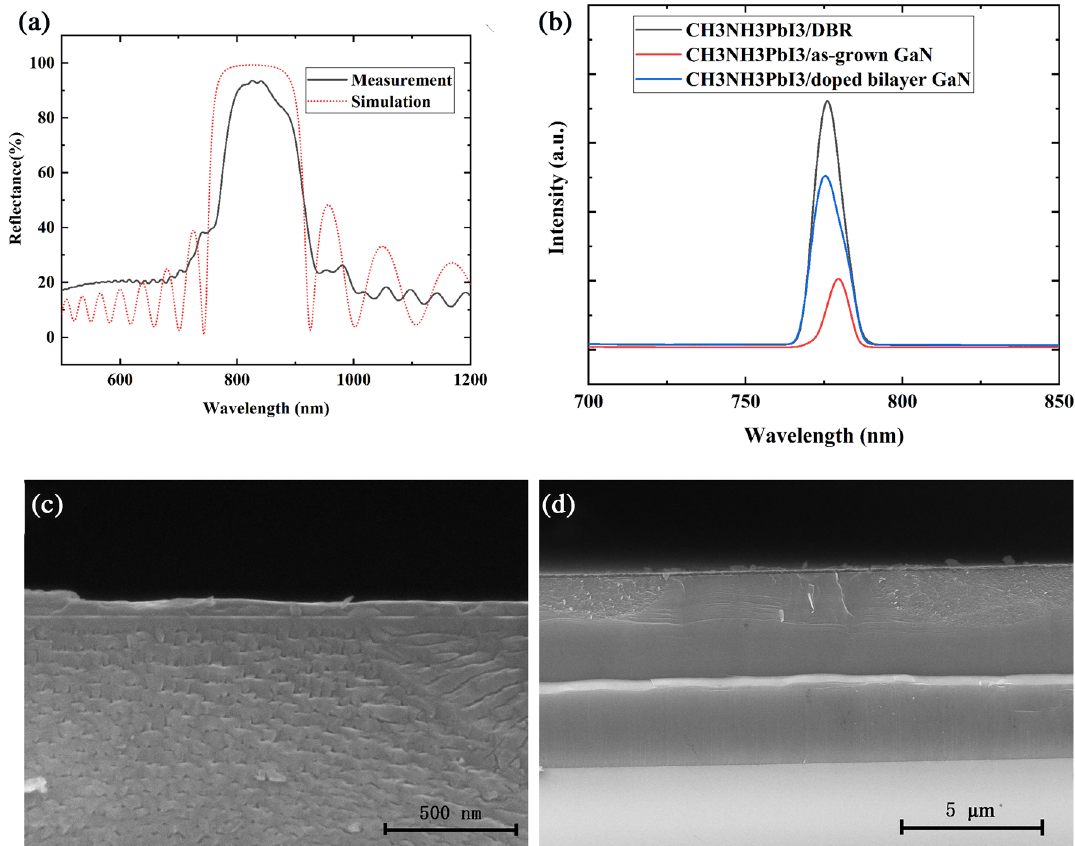
Figure 6. ( a ) The experimental and simulated reflectance spectra of the NP-GaN DBR. ( b ) The room- temperature PL spectra of the prepared perovskite films on the NP-GaN DBR, etched single-layer GaN and as-grown GaN substrates. ( c , d ) The cross-sectional SEM images of CH 3 NH 3 PbI 3 perovskite thin film grown on the etched single-layer GaN substrate with different